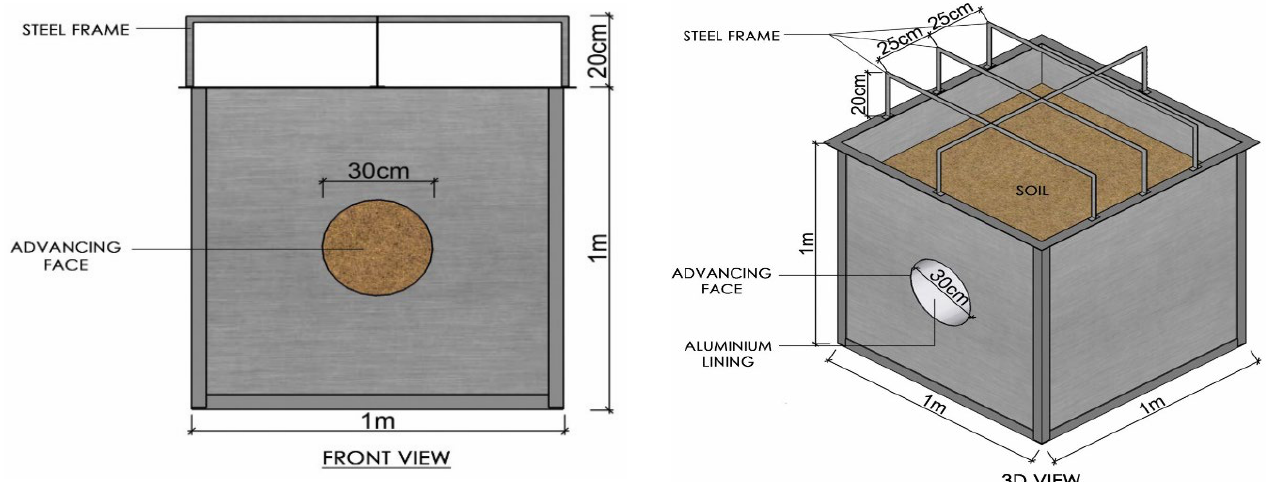
Figure 3. Schematic diagram of lab model.